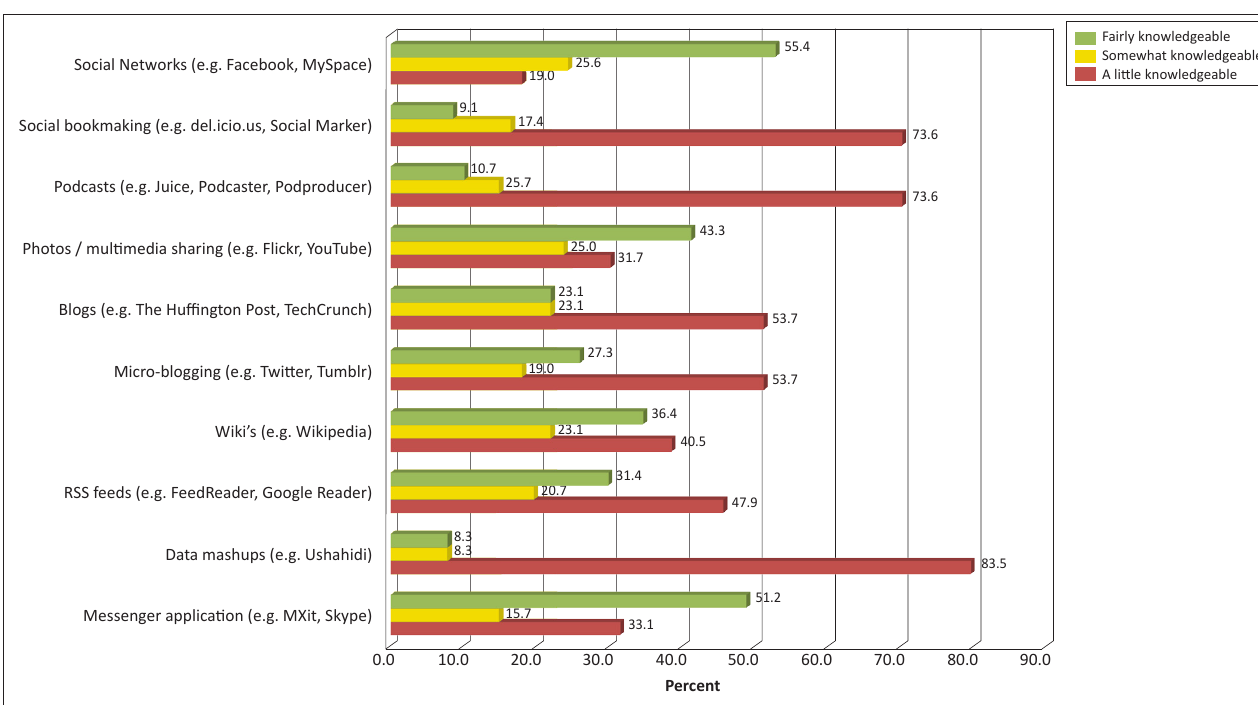
FIGURE 1: Knowledge of social media services in South African civil society organisations.